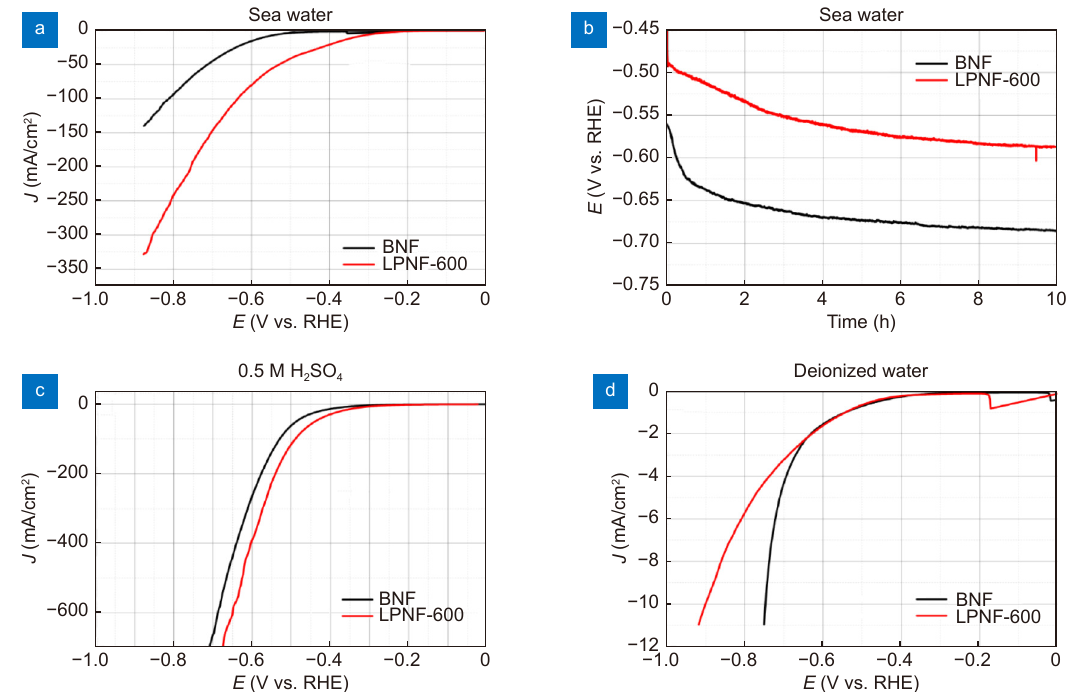
Fig. 5 | LSV curves and chronopotentiometry (CP) test for BNF and LPNF sample in ( a ) seawater solution, ( b ) CP test in seawater, ( c ) 0.5 M H 2 SO 4 , and ( d ) deionized